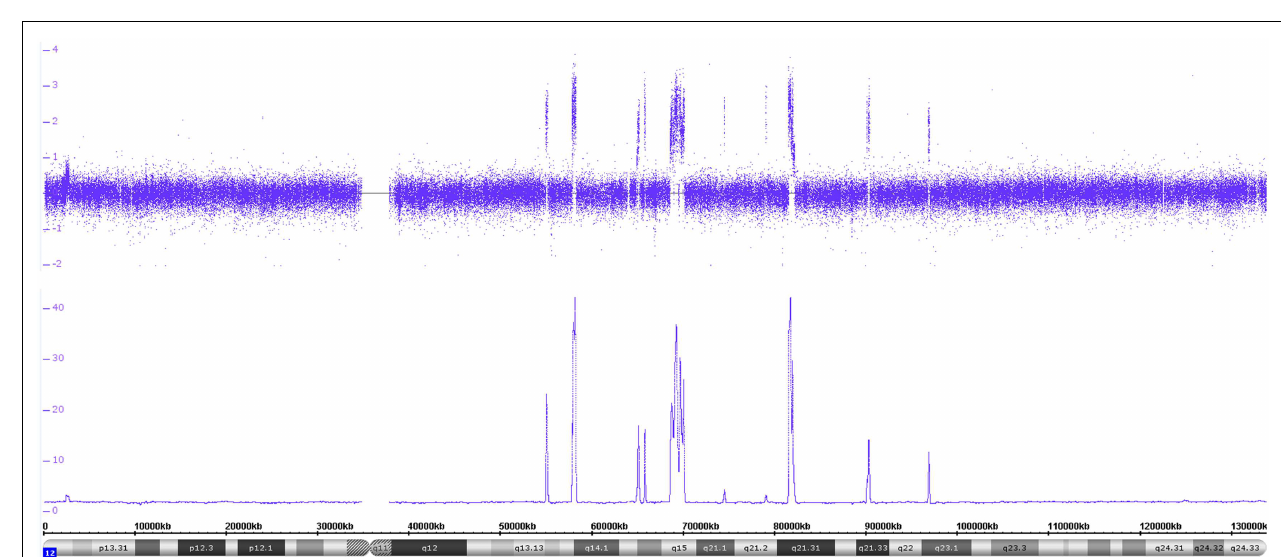
to ~42 copies.The different amplicons contain the following genes MDM2, MDM1 , CDK4 , DCD , INHBC , GLI1 , OS9 , METTL1 , RSSFJ , GNS , MSRB3 , and IL26 besides a number of other